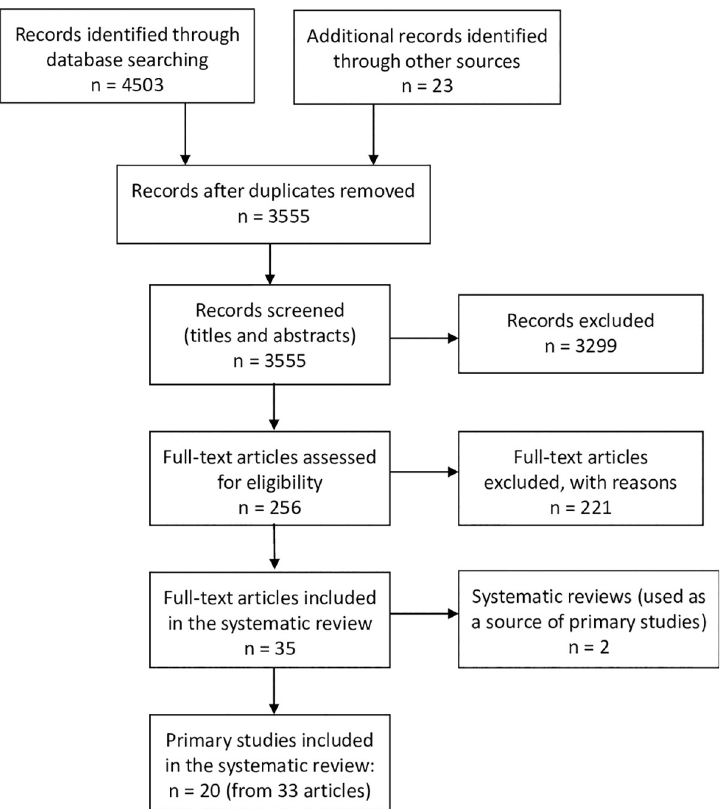
Fig 1. Study selection flow diagram–Preventive chemotherapy for the control of taeniasis by Taenia solium in endemic areas.